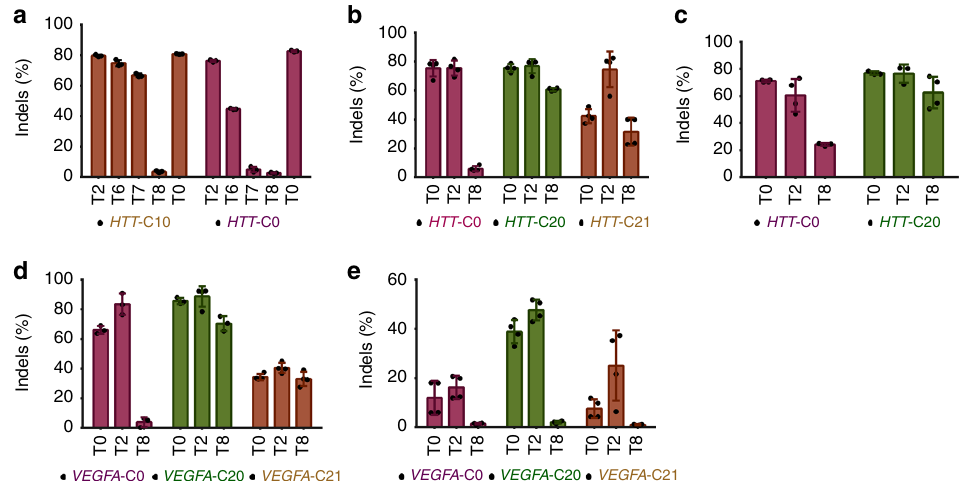
Fig. 4 Targeting endogenous genes with modi fi ed RNAs. a The C10 guide design targeting HTT exon 50 was tested using 20 pmol of RNP along with T2 and T6 – T8 in HEK293T cells. b HTT - C20 and HTT - C21 designs were tested using 80 pmol of Cas9 RNP with the indicated tracrRNAs. c The therapeutically relevant HBB locus was targeted using a previously validated guide sequence incorporated into the C20 design. d , e VEGFA -targeting crRNAs C20 and C21 were tested using the indicated tracrRNAs with 80 pmol of RNP in HEK293T cells ( d ) or 60 pmol of RNP in hESCs ( e ). Indels were calculated using TIDE. Bars show averages (±SD) of at least three biological